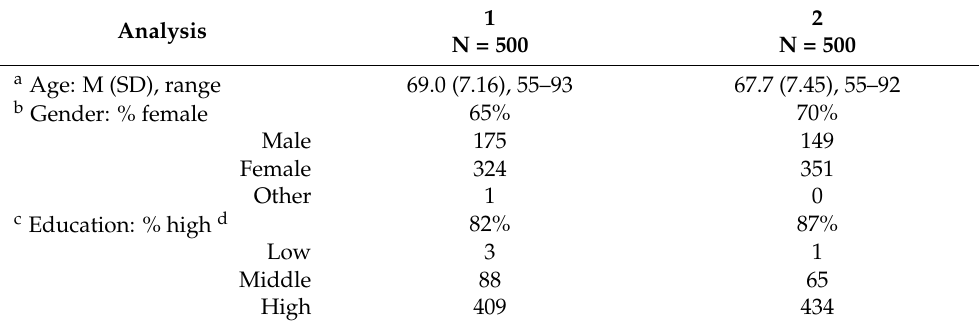
Table 1. Demographic characteristics of samples included in Analysis 1 and